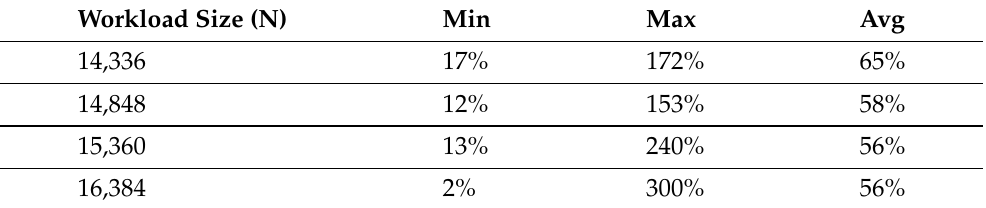
Table A1. Prediction errors of Intel RAPL against ground-truth for dynamic energy consumption by